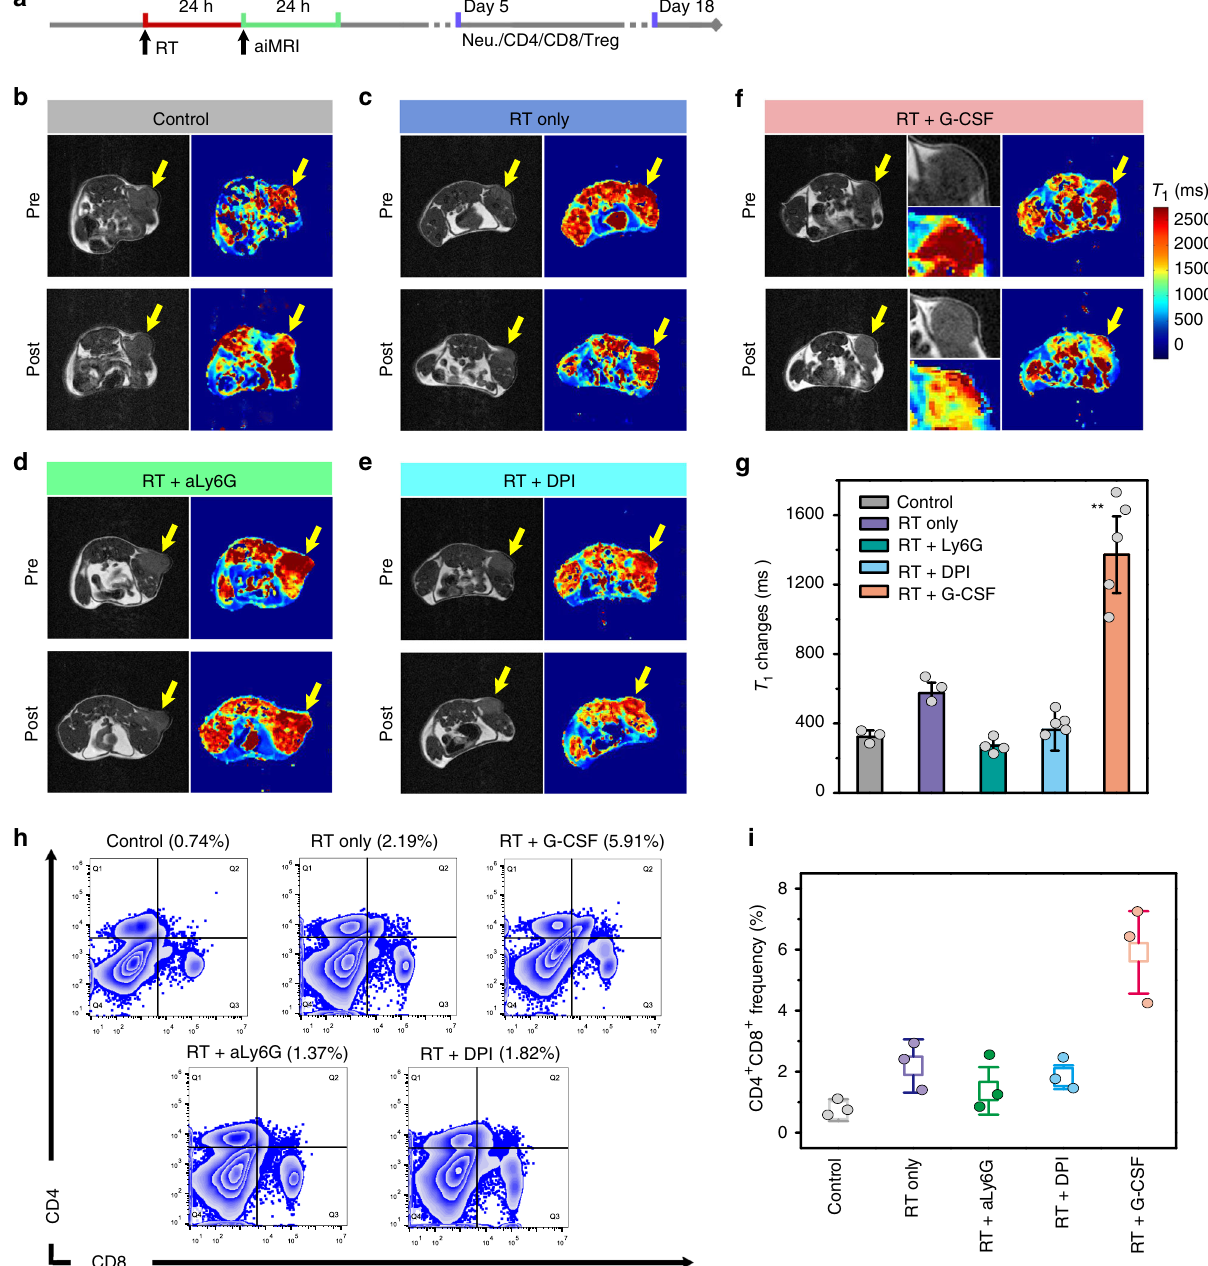
Fig. 5 The aiMRI study in Balb/c mouse 4T1 tumor models. a Scheme shows the procedure time points of the radiotherapy (RT) study. b – f The pre- and post-contrast T 1 phantom images and the quantitative T 1 relaxation maps of mouse tumors after receiving control, RT (15 Gy) only, RT + aLy6G, RT + DPI, and RT + G-CSF, respectively. Yellow arrows indicate mouse tumors. The mouse tumor is magni fi ed in the middle for the RT + G-CSF panel. g Quantitative T n = 5 biologically independent mice, ** P = 0.0014, one-tailed homoscedastic t -test). h , i Flow cytometry 1 relaxation time changes in mouse tumors ( analysis and quanti fi cation of the CD4 + CD8 + T cells in the splenocytes of mice at 5 days after different treatments ( n = 3 biologically independent mice). All error bars indicate mean ±